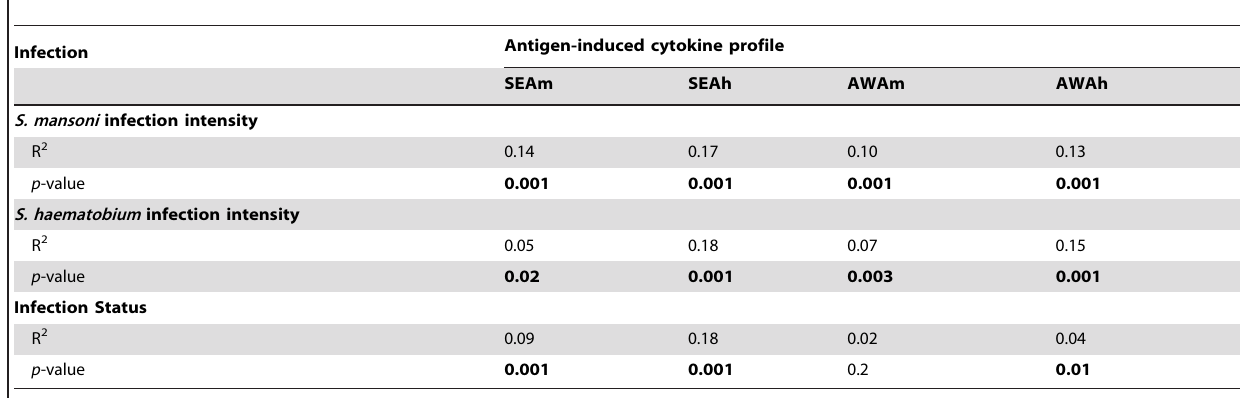
Table 4. Association between Schistosoma infection and Schistosoma antigen-induced cytokine profiles.